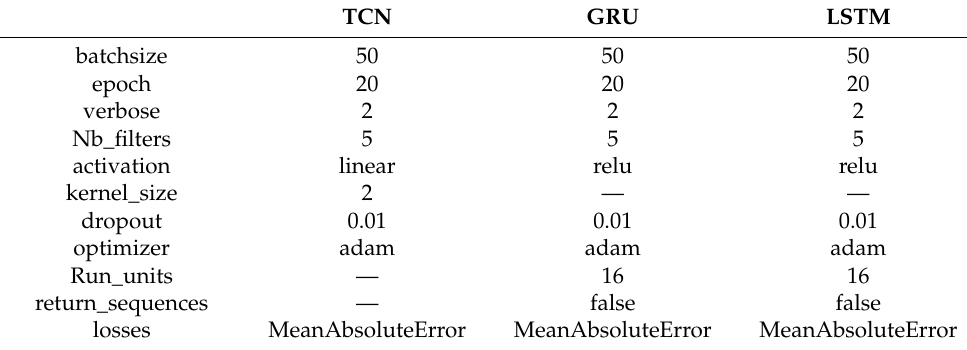
Table 6. Parameter Settings of Each